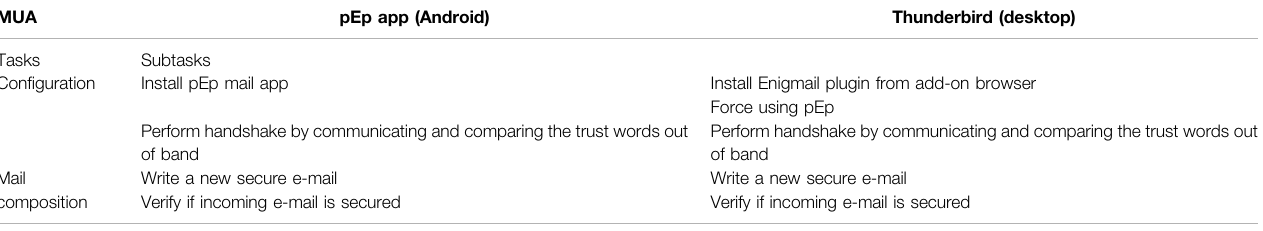
TABLE 9 | Analysis of pEp tasks with two MUAs. MUA pEp app (Android) Thunderbird (desktop)